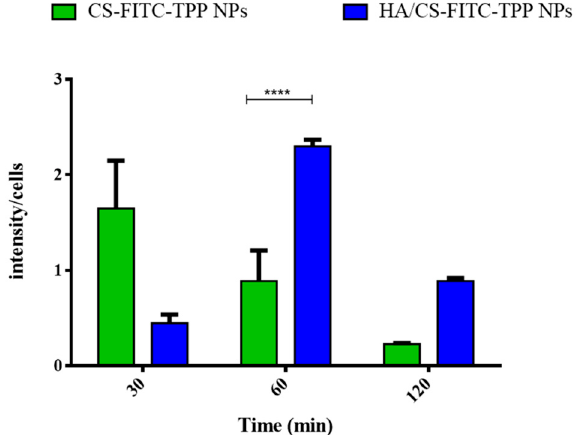
Figure 10. Quantitative evaluation of the cellular uptake studies performed on MSc from the broncoalveolar lavage of the bronchiolitis obliterans syndrome (BOS)-affected patients with HA/CS-FITC-TPP NPs at 37 °C. CS-FITC-TPP NPs were used as the control. The results are expressed as fluorescence intensity/cell vs. time, as showed in the histogram. The data represent the mean ± SD ( n = 3). Statistical significance was determined using the Holm–Sidak method (multiple t test), with α < 0.05 (*). Tukey’s multiple comparisons test reveals a significant difference (****) for p values <